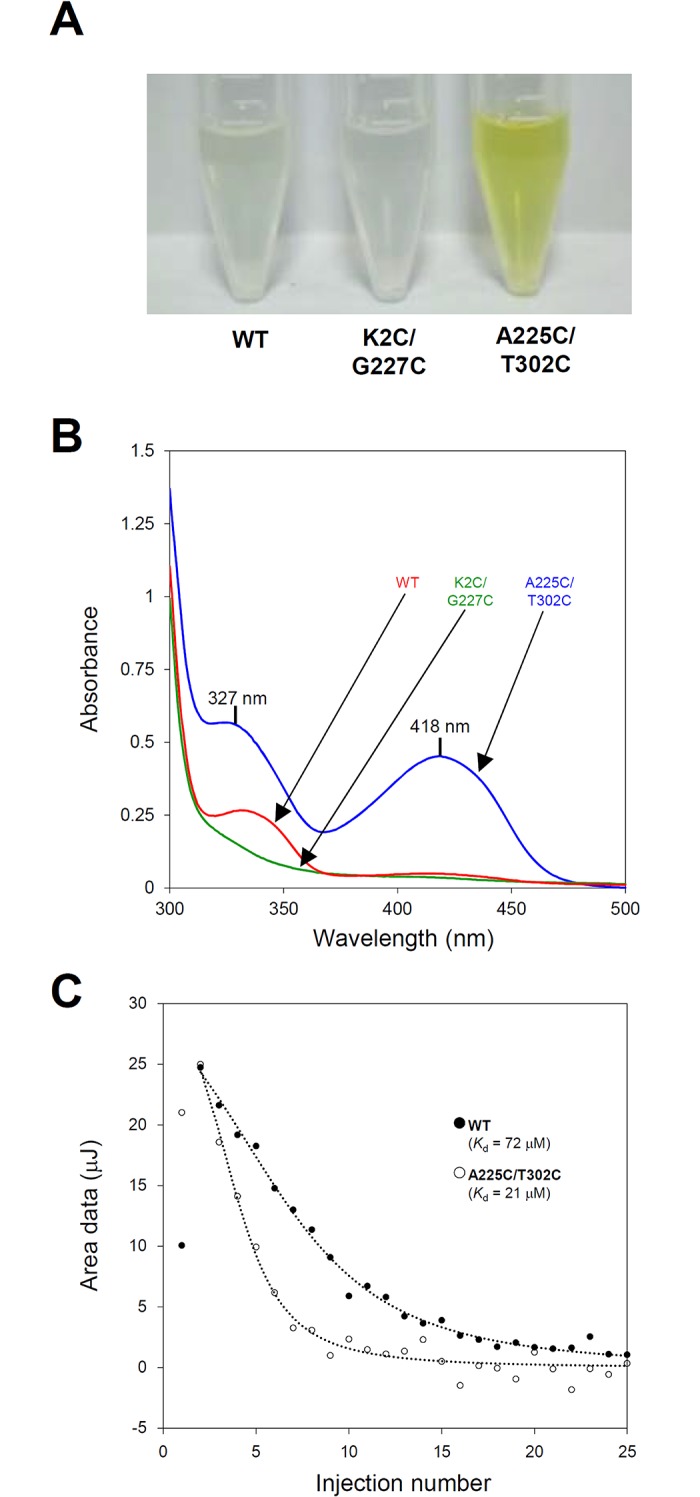
Enhanced PLP affinity in the SrLDCA225C/T302C mutant.(A) Purified recombinant SrLDC proteins. The purified SrLDCWT, SrLDCK2C/G227C, and SrLDCA225C/T302C proteins with concentration of 1 mg/ml are shown. (B) UV/vis spectra of recombinant SrLDC proteins. The UV/Vis absorption spectra of recombinant SrLDC proteins are shown and labeled appropriately. The band peaks of 327 nm and 418 nm observed in the SrLDCA225C/T302C mutant are indicated. (C) Isothermal titration calorimetry of SrLDCWT and SrLDCA225C/T302C mutant. Kd values of SrLDCWT and the SrLDCA225C/T302C mutant are displayed.